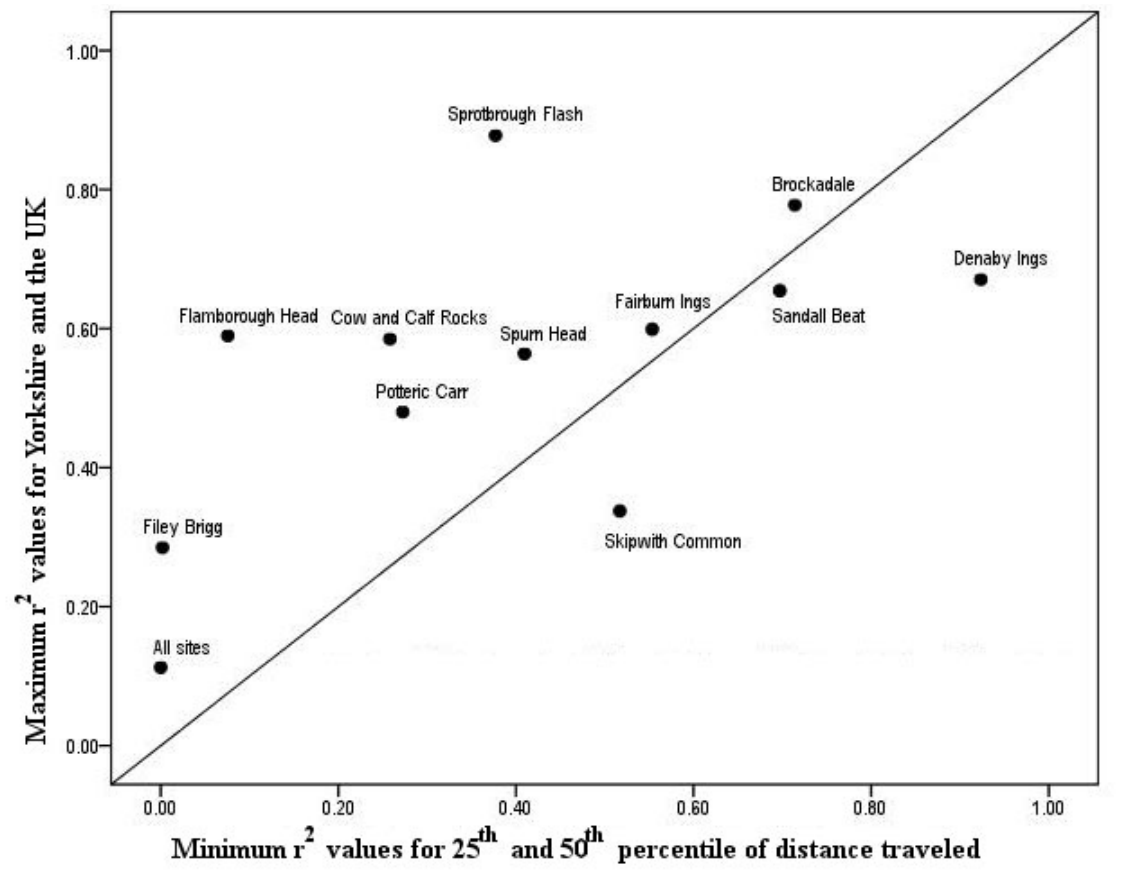
Fig. 6 . Scatter plot showing minimum r 2 values for Mosaic groups by site ( n = 11) for the 25 th and 50 th percentiles of distance traveled against maximum r 2 values from Yorkshire and the UK. Results of aggregated site correlations against Yorkshire and the UK (all sites) are shown for reference. Sites situated below the line show the effects of